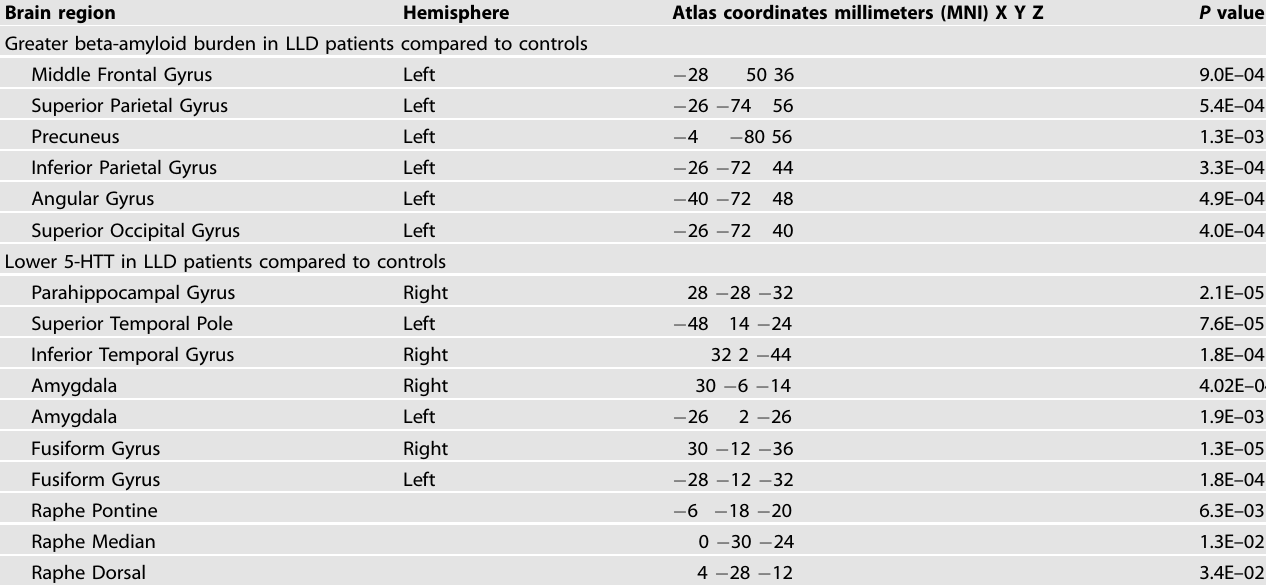
Higher Beta-Amyloid (top section) and lower serotonin transporter availability (bottom section) was observed in Late-Life Depressed (LLD) Patients than normal controls, applying the Monte-Carlo Simulation Method (uncorrected P = gyrus (left) and superior occipital gyrus (left). The mean A β DVRs for the total cortex and the left precuneus were 1.13 ± 0.63 and 1.24 ± 0.09 for the controls and 1.17 ± 0.16 and 1.31 ± 0.24 for the LLD patients based on volume of interest analysis [13].